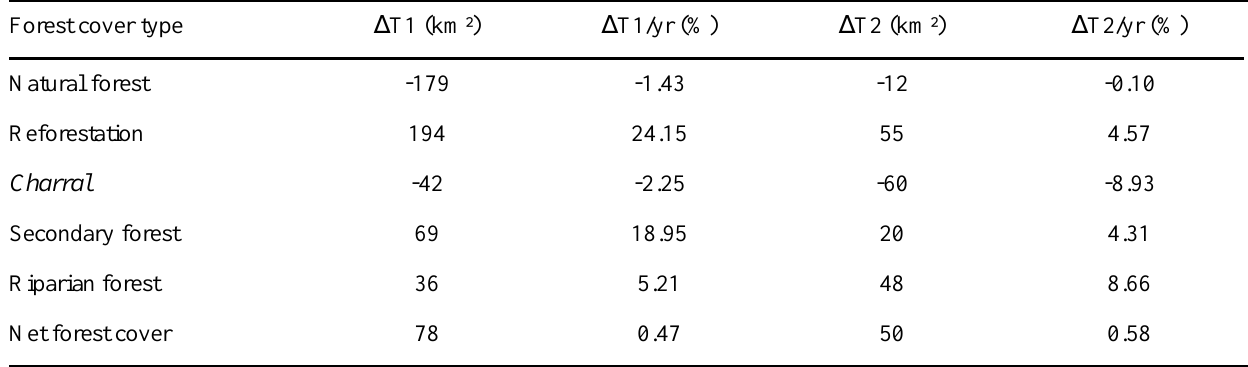
Table 1 . The amount of forest lost or gained during each time period and the annual rate of change estimated using the formula by Puyravaud (2003). D T1 represents 1986–1996, and D T2 represents 1996–2001. Net forest cover includes all five forest